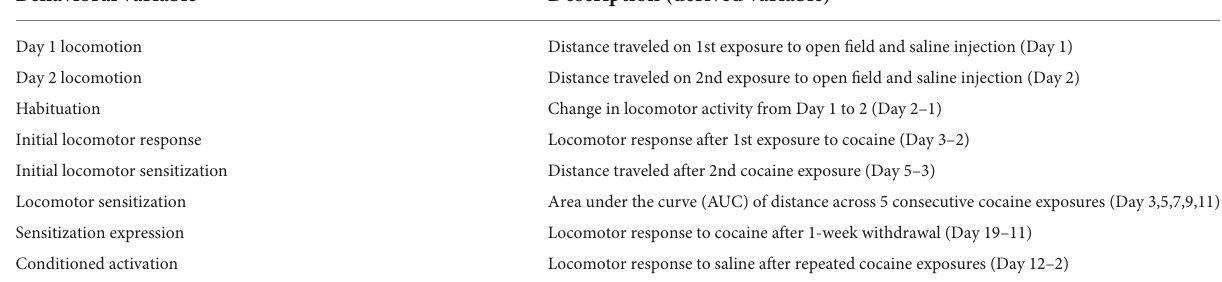
TABLE 2 Derived variables calculated from 19-day behavioral sensitization data. Behavioral variable Description (derived